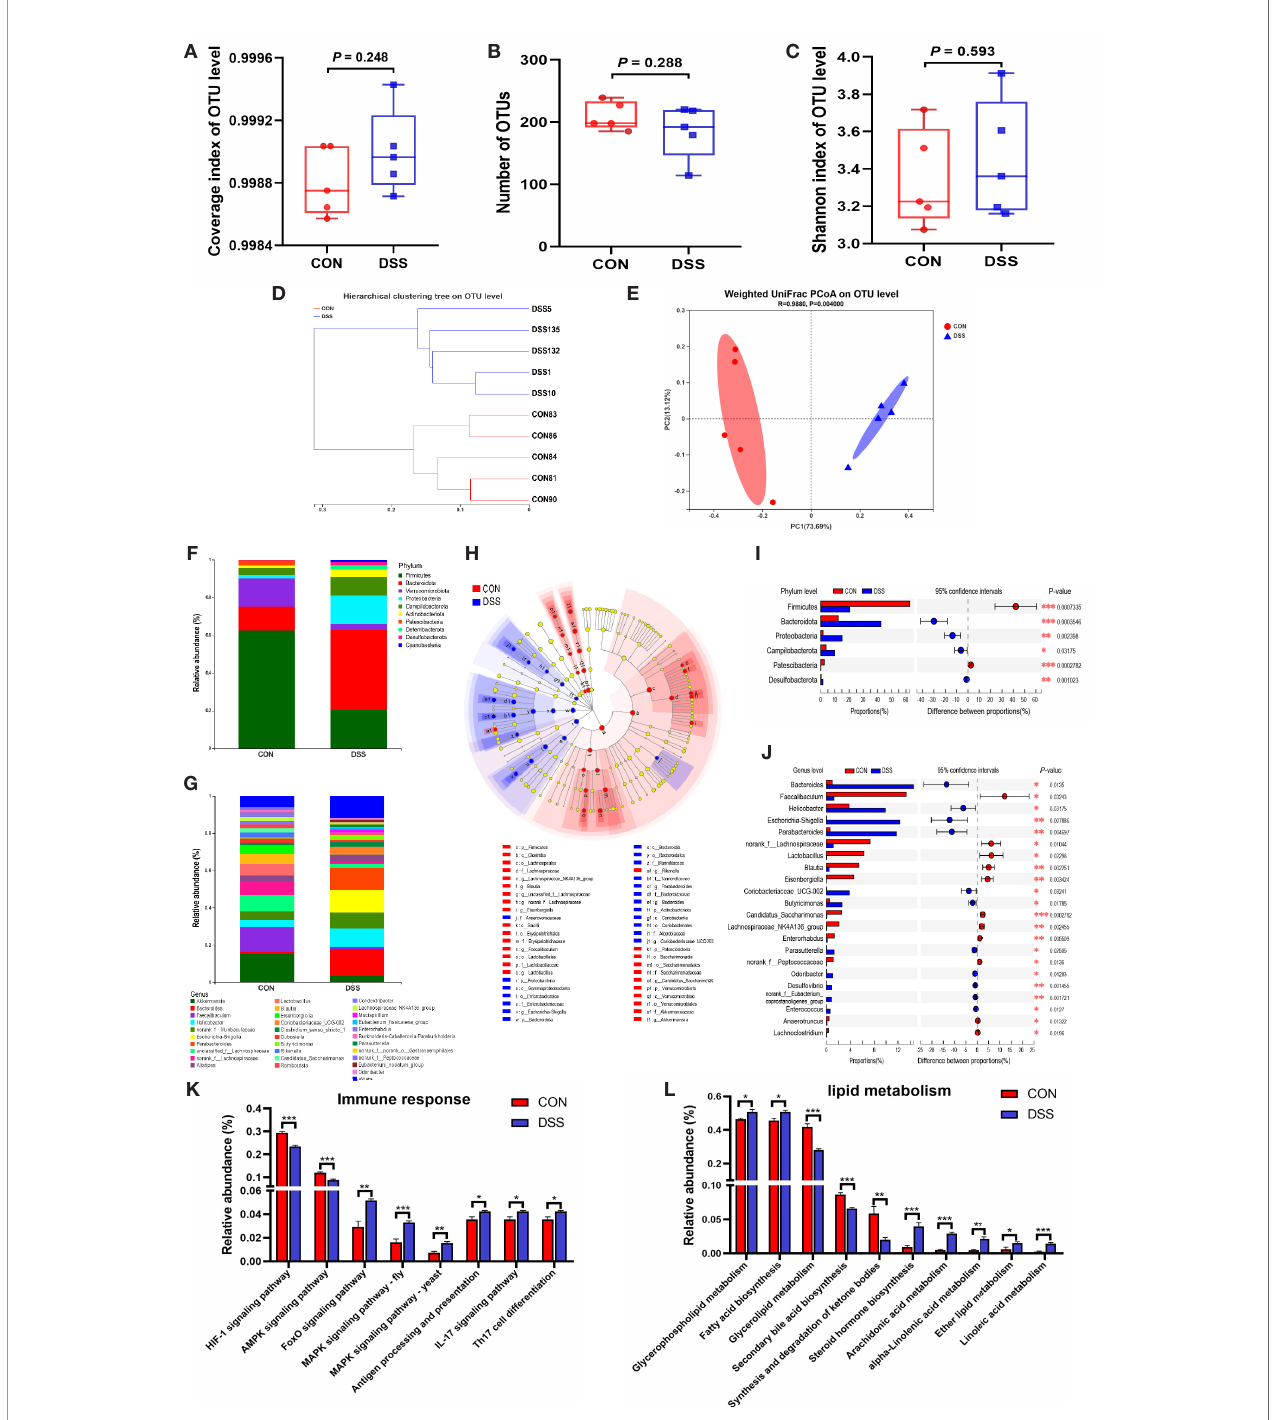
FIGURE 3 | Alterations in the gut microbiota of mice with DSS-induced colitis. (A) Coverage index of OUT level; (B) Number of OTUs; (C) Shannon index of OUT level; (D, E) b -diversity was estimated by the hierarchical clustering tree (D) and PCOA (E) on OUT level; (F, G) The relative abundance of bacteria at the phylum (F) and genus (G) levels; (H) Cladogram of LEfSe multi-level species difference discriminant analysis (LDA > 4), different color nodes indicate microbial communities that are signi fi cantly enriched in the corresponding groups and signi fi cantly different between groups; (I, J) Comparative analysis of the relative abundance of bacteria at the phylum (I) and genus (J) levels; (K, L) The different abundances of gut microbiota at immune response (K) and lipid metabolism (L) pathways. Data were expressed as means ± SEM (n = 5). * P < 0.05, ** P < 0.01, *** P <